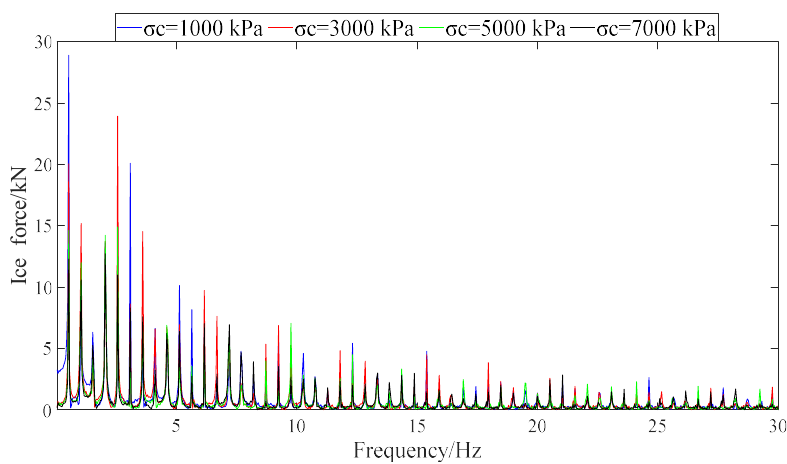
Figure 23. Frequency domain curves with different crushing strength ( σ c ).